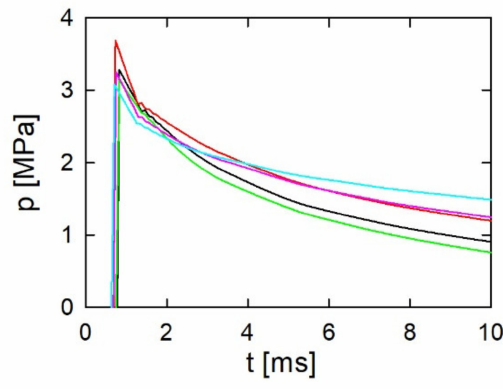
Figure 6. Pressure courses for the empty